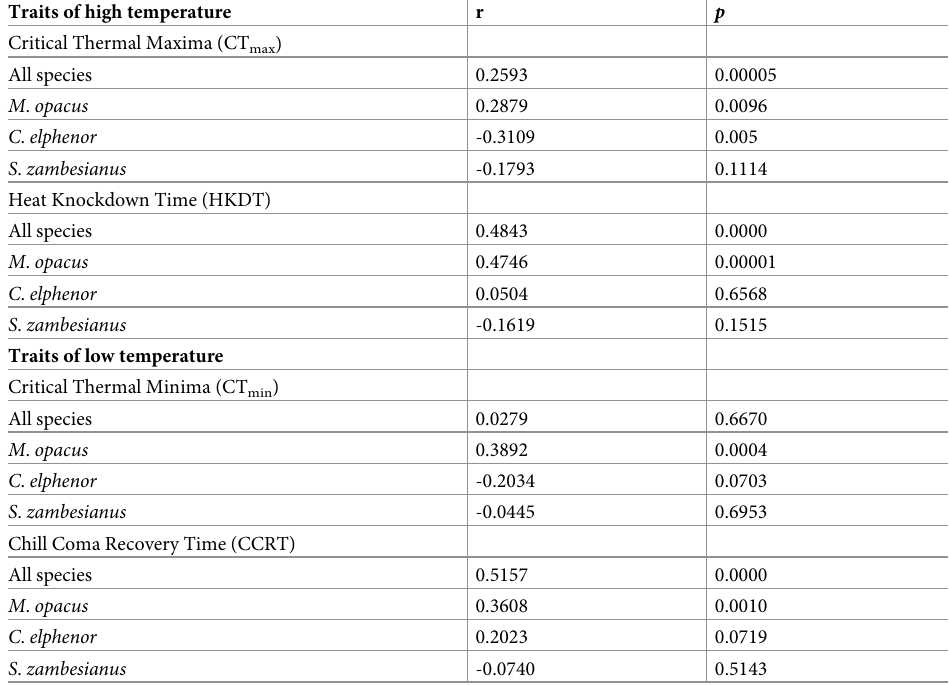
Table 2. The relationship between traits of high and low temperature tolerance and body water content (BWC). Analysis was performed using linear regression in STATISTICA. Dung beetle species BWC were correlated with traits of temperature tolerance independently and then all species combined. R represents the coefficient of correlation.